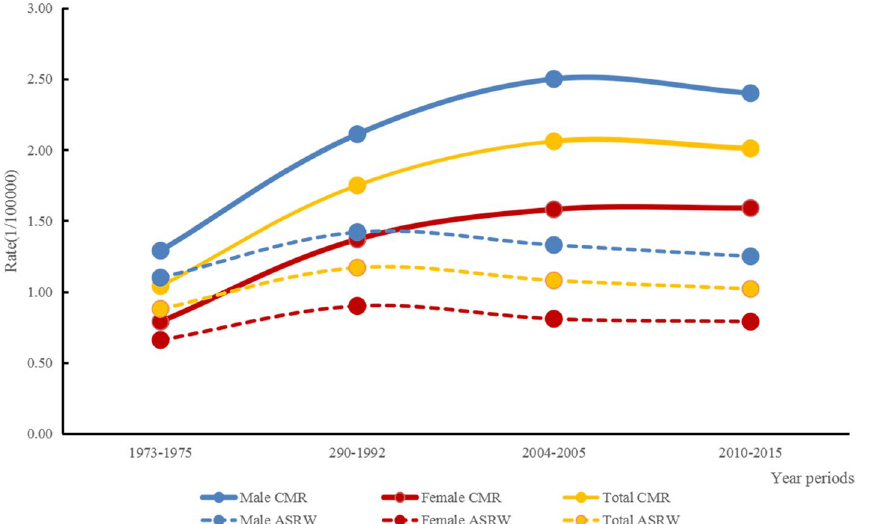
Figure 1. Mortality trend of younger lung cancer in Hebei Province by population-based database,